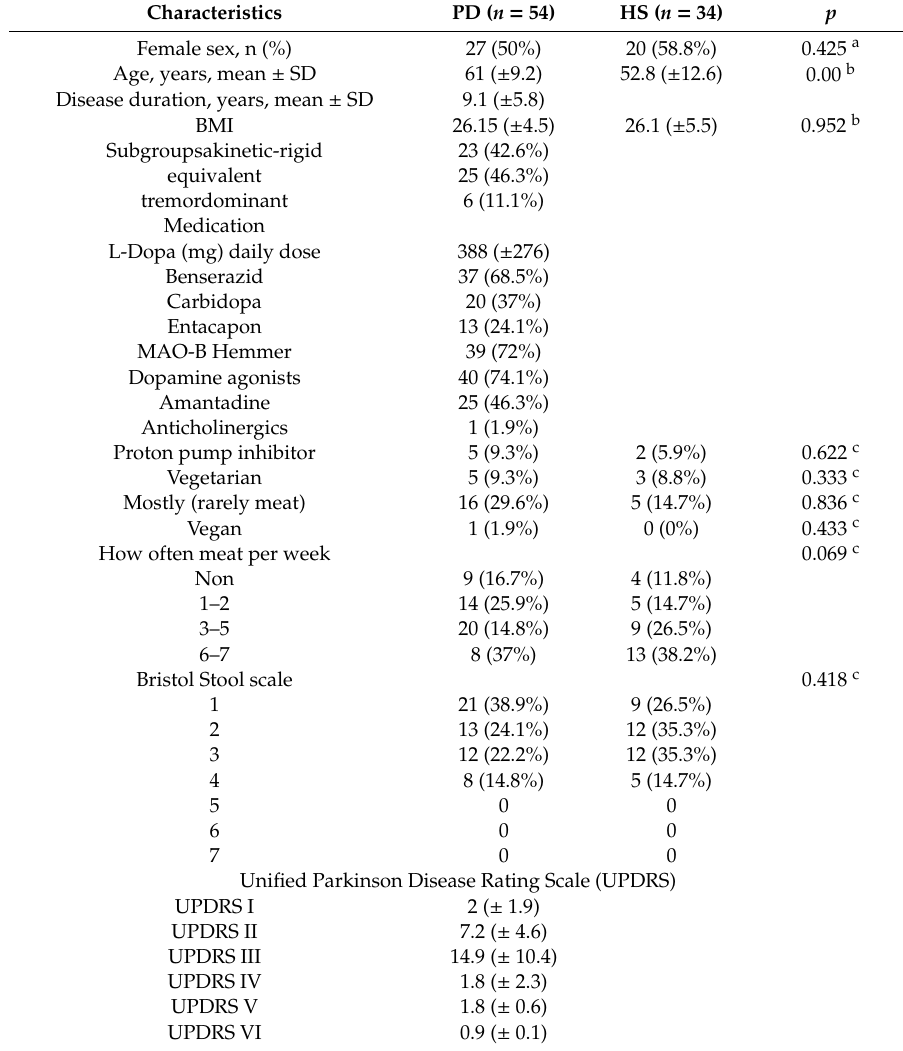
Table 1. Demographic data and characteristics including standard deviation or percentage data of patients without therapeutic intervention and healthy subjects (the given data are complete for all participants).